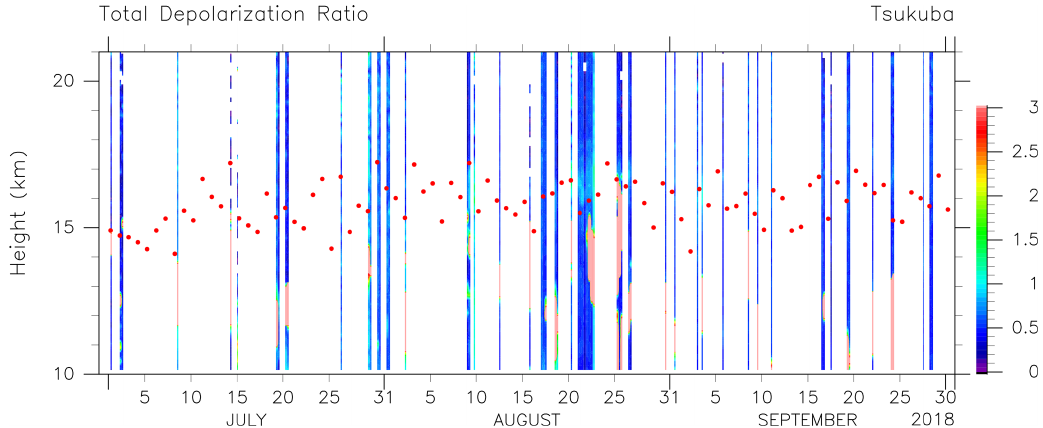
Figure A1. As for Fig. 1, but for the total depolarization ratio (TDR, %).